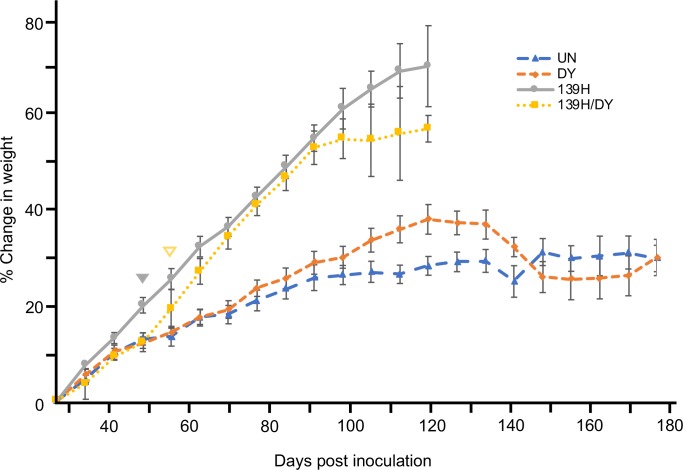
Effect of prion infection on weight gain over the incubation period of disease.Hamsters were inoculated with either uninfected brain homogenate (blue triangles), DY-infected brain homogenate (orange diamonds), 139H-infected brain homogenate (gray circles) or an equal mixture of 139H and DY-infected brain homogenate (yellow squares) and their weights were recorded weekly. Solid grey triangle and open yellow triangle indicates when the weight of 139H-infected or 139H/DY co-infected hamsters, respectively, significantly (p<0.05) differed from mock-infected animals.